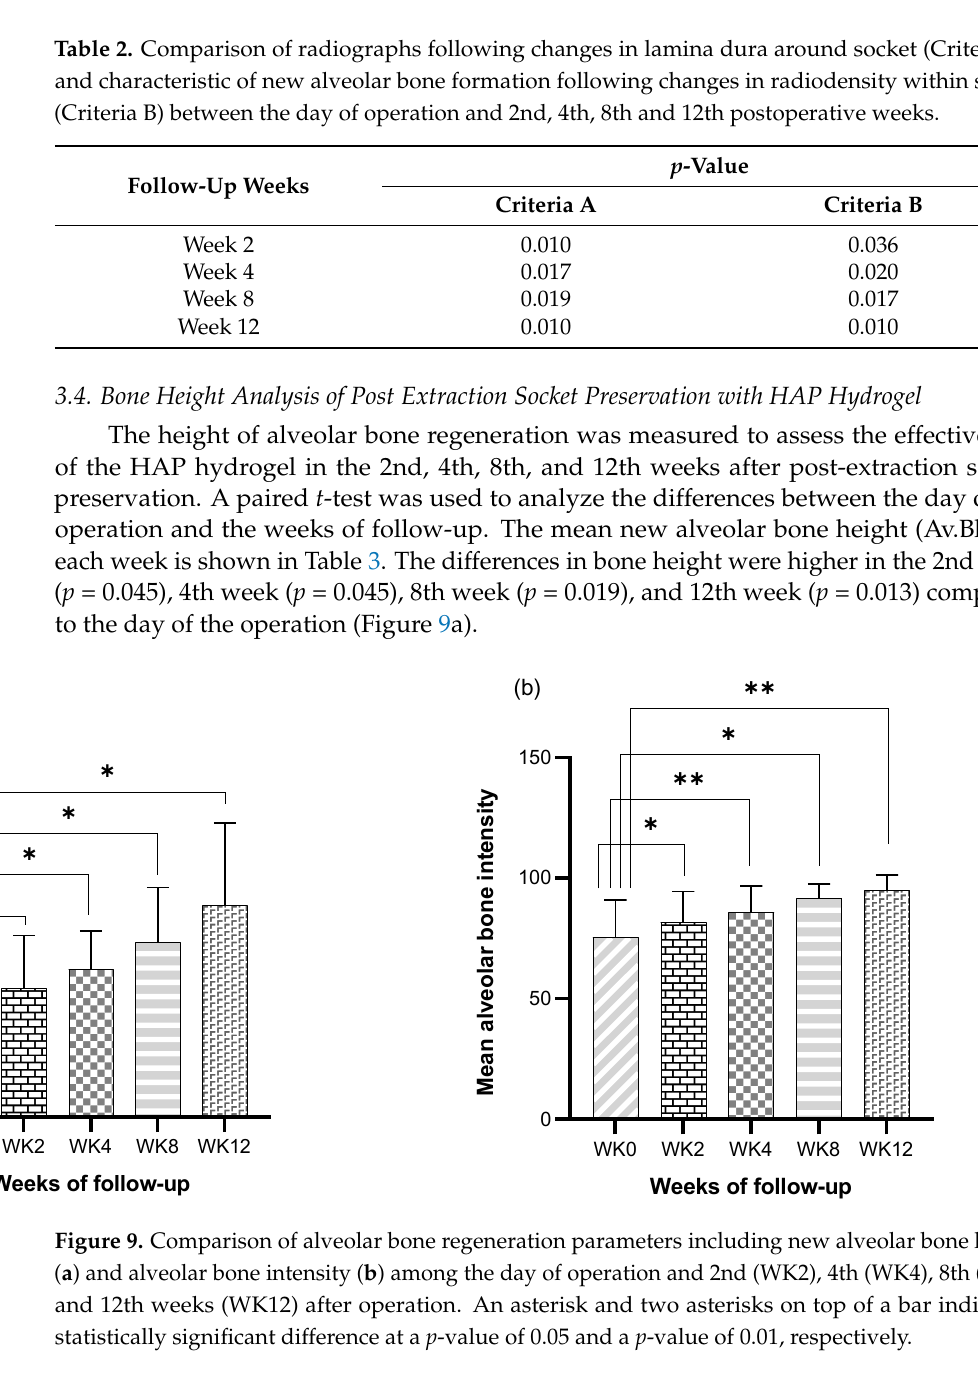
Table 3. The mean and standard deviation of new alveolar bone height (Av.Bh) and alveolar bone